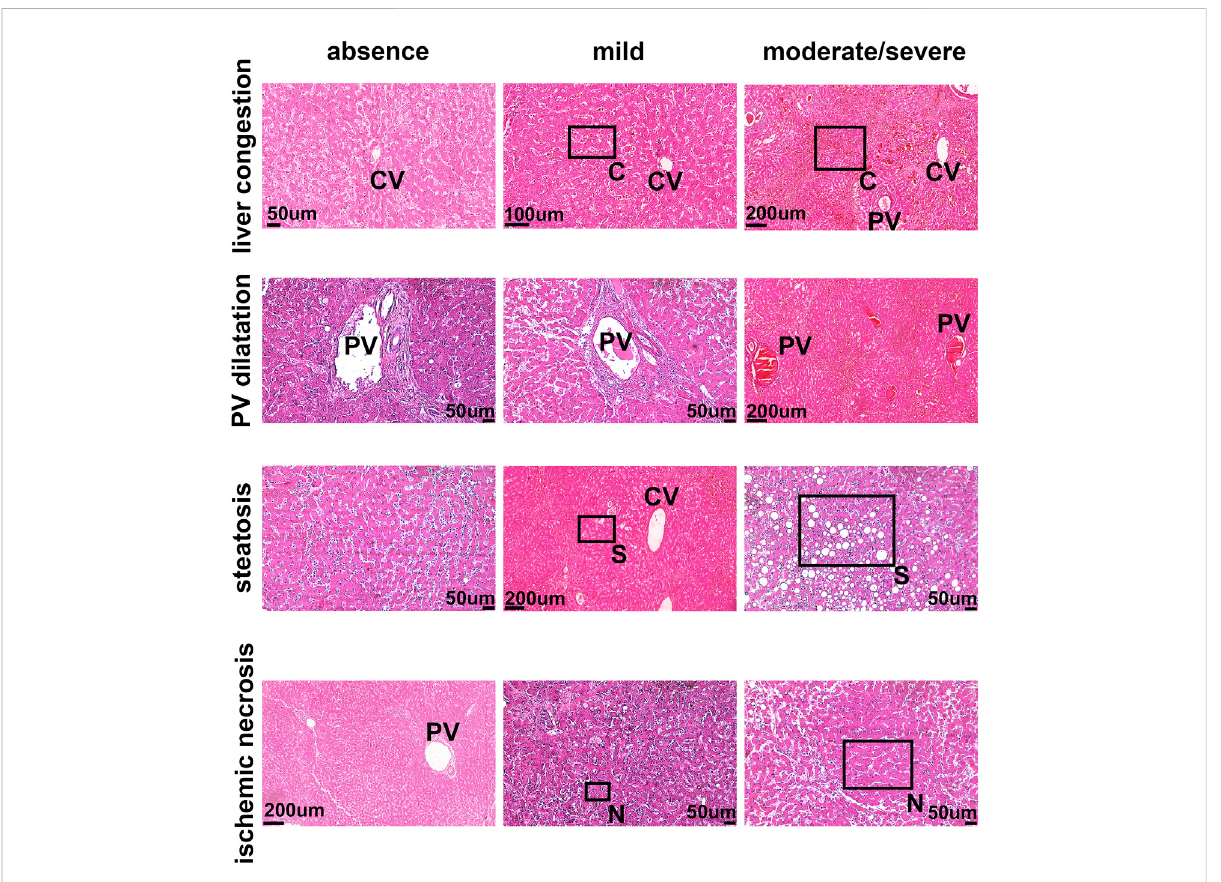
FIGURE 2 The pattern of liver damage in COVID-19 patients. The pattern of liver damage in hematoxylin and eosin staining images is representative of absent, mild, and moderate/severe. PV – Portal Vein; CV – Central Vein; C – Congestion; S – Steatosis N – Necrosis. Demarcated areas highlighted in some panels indicate congestion, steatosis and ischemic